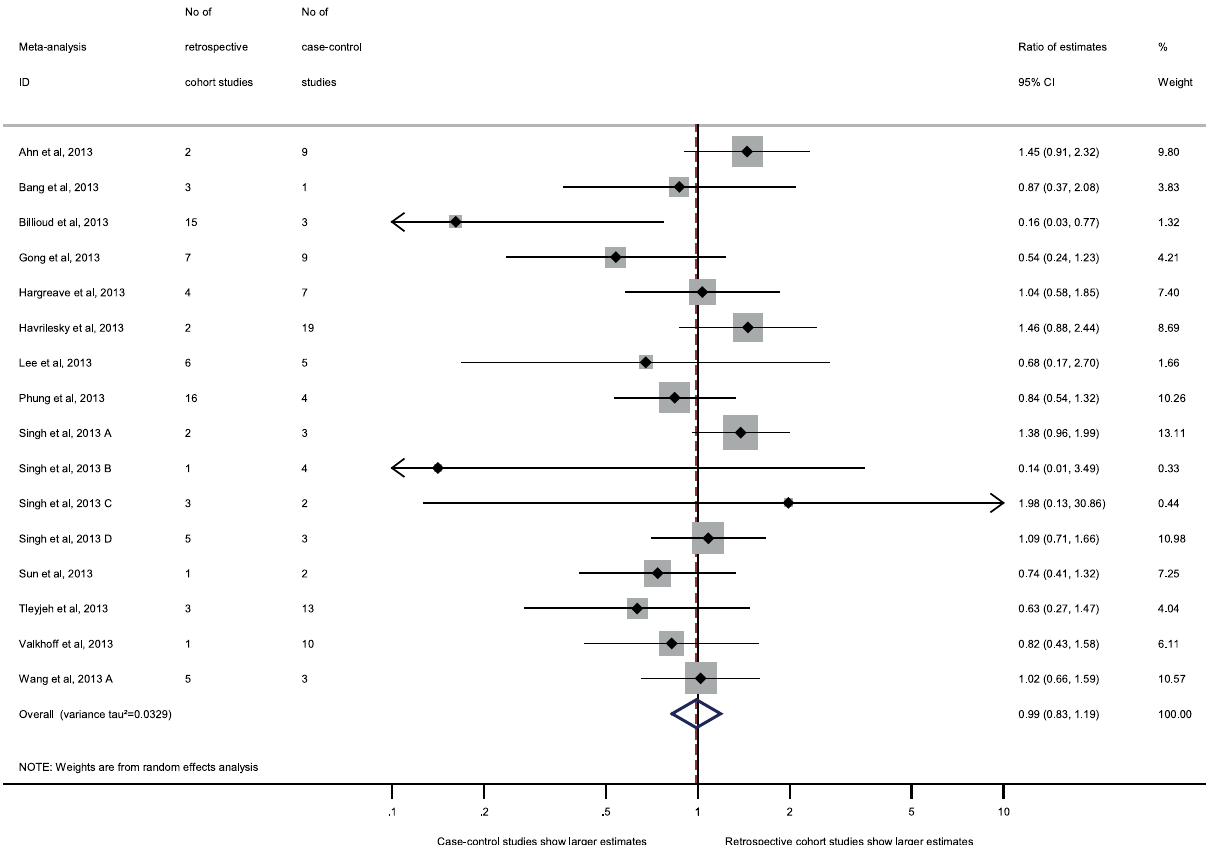
adverse events than retrospective cohort